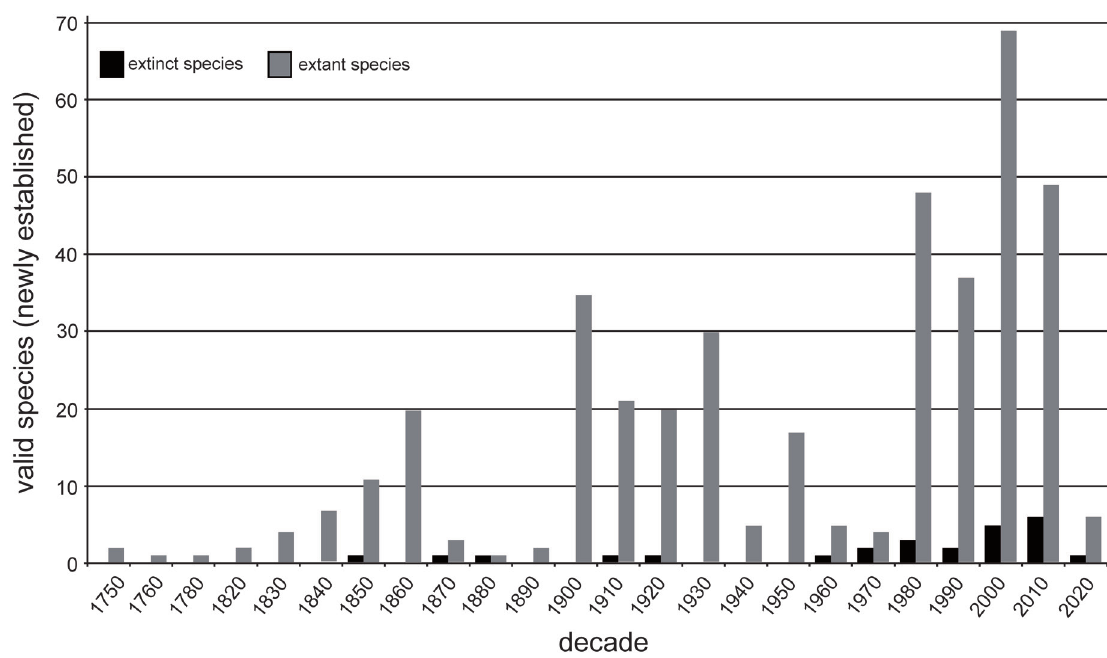
Fig. 2. Valid extant and extinct species of world Megaloptera established by decade; each species is attributed to the decade in which its currently valid species group-name was established. Subspecies are excluded.